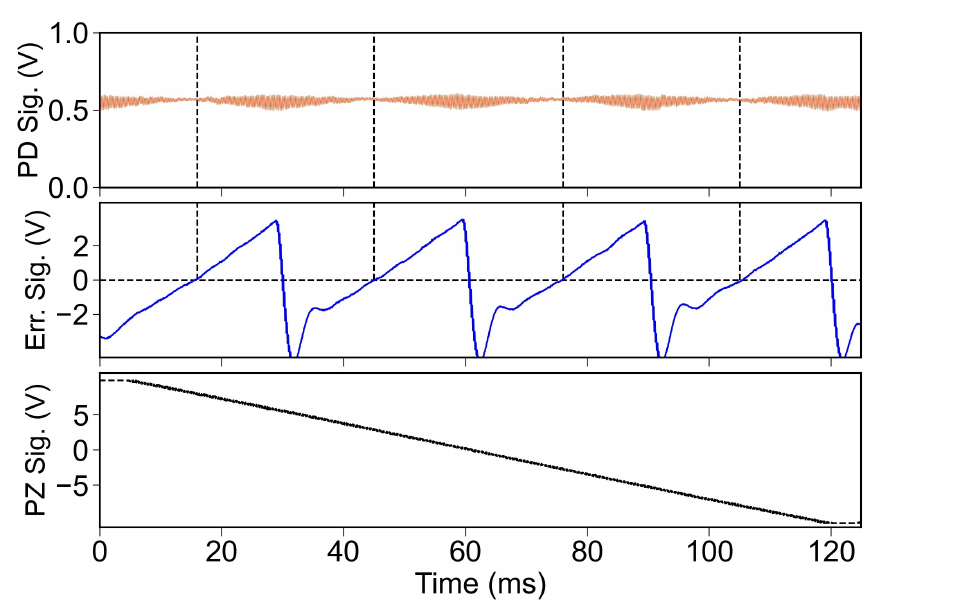
Figure 2. PD and error signals in CW-only mode—scanning.